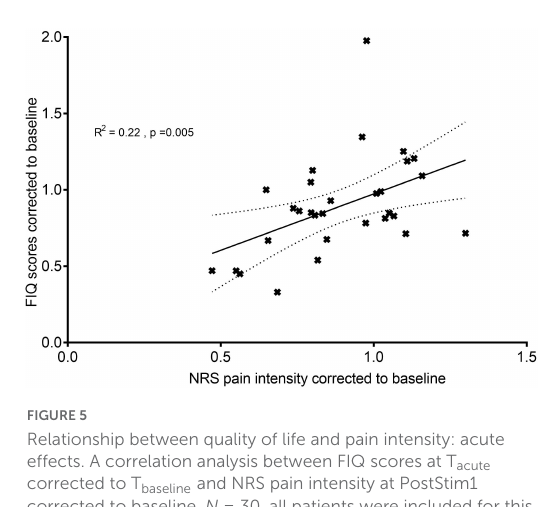
FIGURE3 Pain intensity scores as cataloged by NRS during and after concurrent meditation and tDCS intervention. Bars show standard error of mean. ∗∗ p < 0.01.